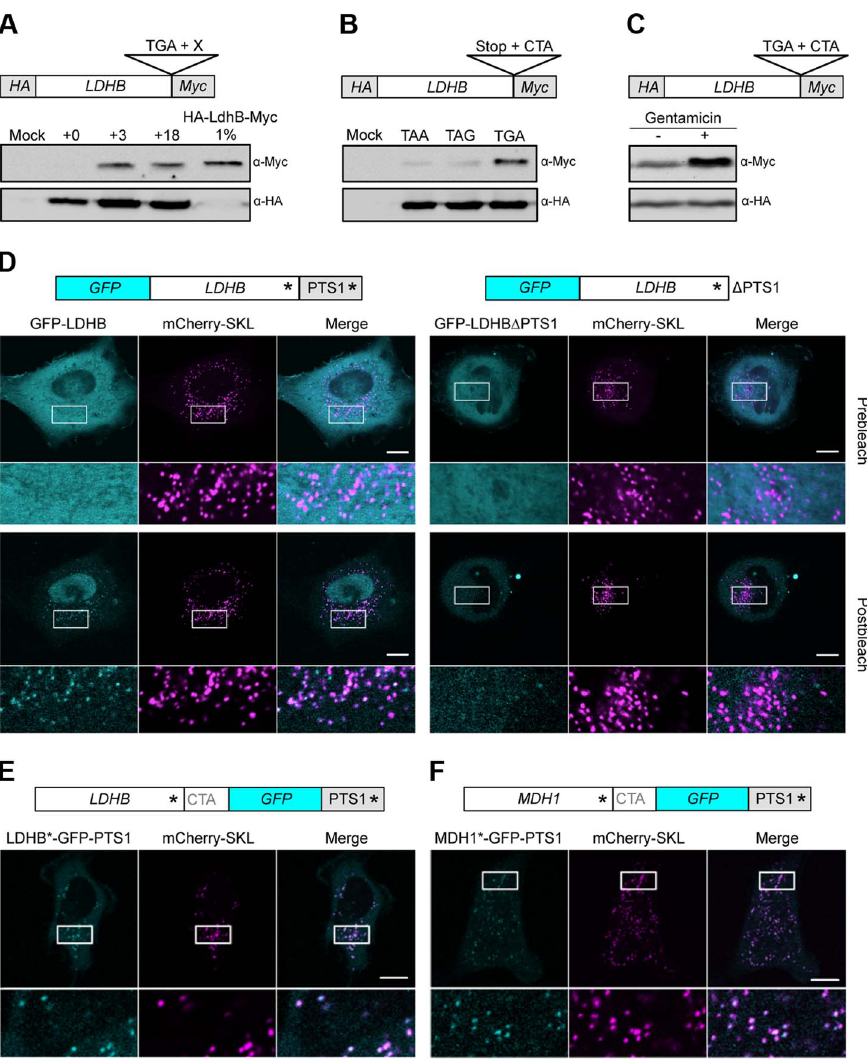
Figure 5. Analysis of peroxisomal targeting of LDHB via translational readthrough in HeLa cells. (A) Western blot analysis of LDHB derivatives fused to HA and Myc. (B) The stop codon of the LDHB construct described in (A) was exchanged by TAA and TAG. (C) Western Blot analysis of LDHB fused to HA and Myc in dependence on Gentamicin ( + ). (D) GFP-LDHB and GFP-LDHB D PTS1 were co-expressed with the peroxisomal marker mCherry-SKL. (E) LDHB*-GFP-PTS1 was co-expressed with mCherry-SKL. (F) MDH1*-GFP-PTS1 was co-expressed with mCherry-SKL. Asterisks mark the positions of stop codons. PTS1 indicates the peroxisomal targeting signal downstream of the conventional stop codon of LDHB and MDH1, respectively. Intracellular localization was followed by fluorescence microscopy before and after repeated photobleaching. Magnified areas are indicated and shown below the micrographs. Scale bars represent 10 m m.